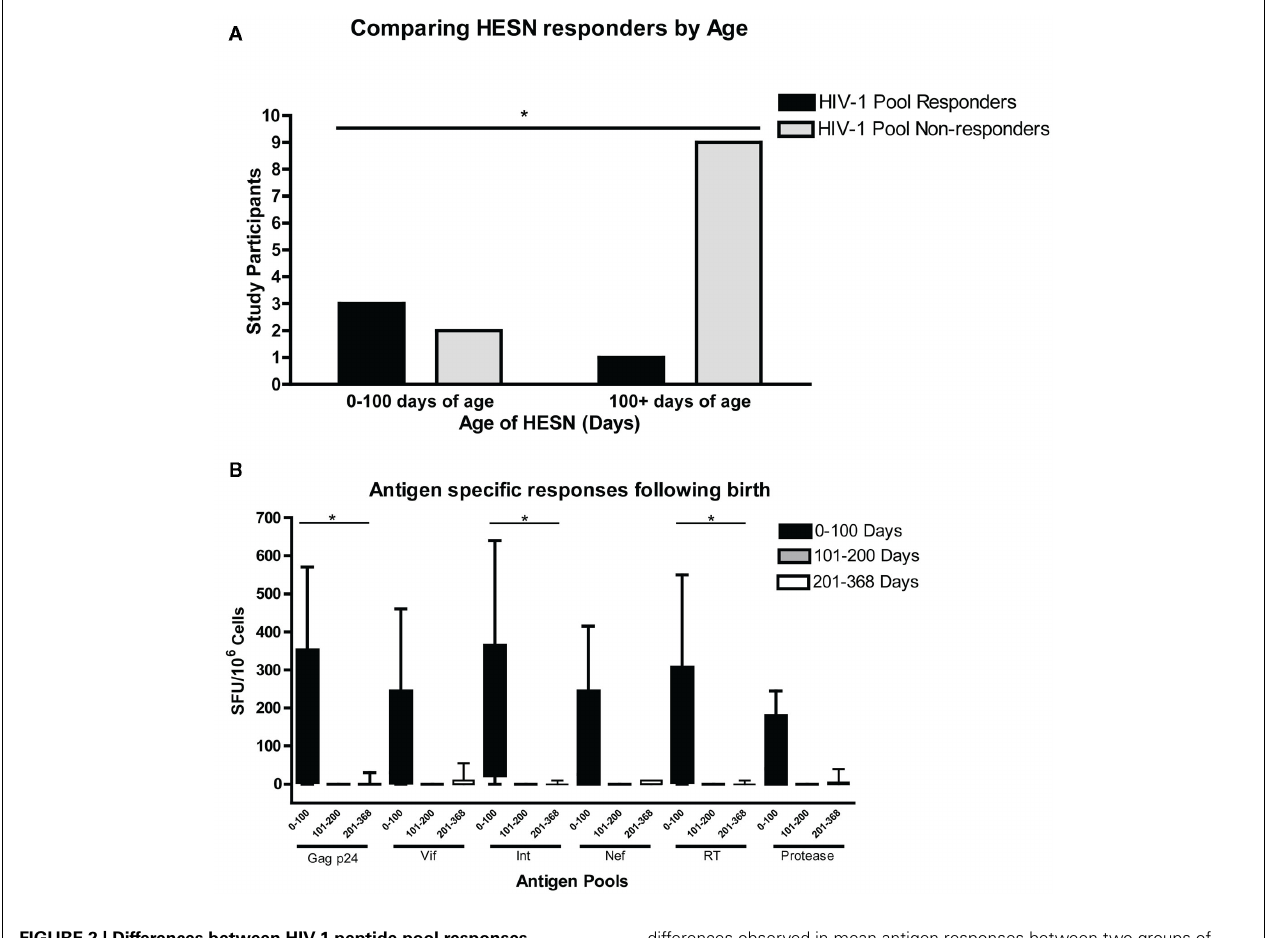
FIGURE 2 | Differences between HIV-1 peptide pool responses between infants under, and infants over 100days of age were found significant ( p = 0.039, Chi-square) (A). Responses were predominantly found within the first 100days from birth, with Statistically significant